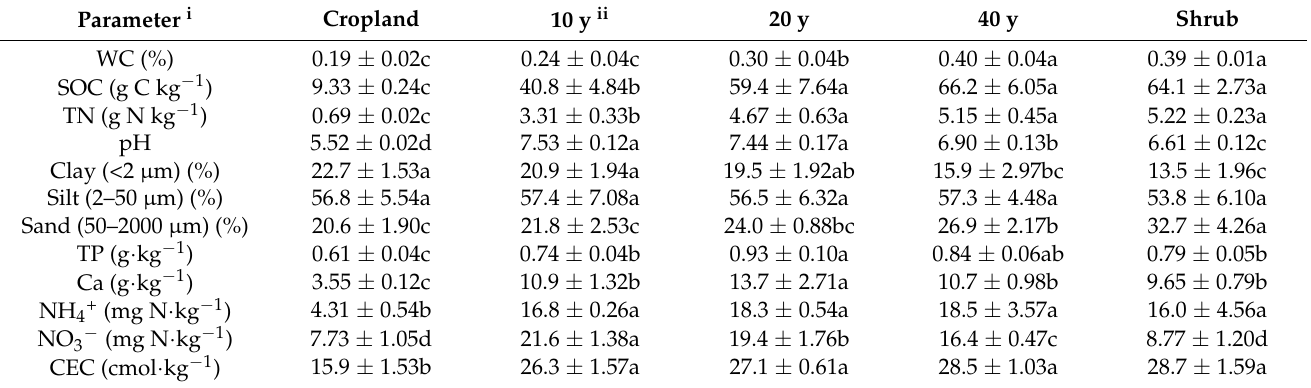
Table 1. Changes in physicochemical properties in soils with different afforestation years of D. viscosa . Parameter i Cropland